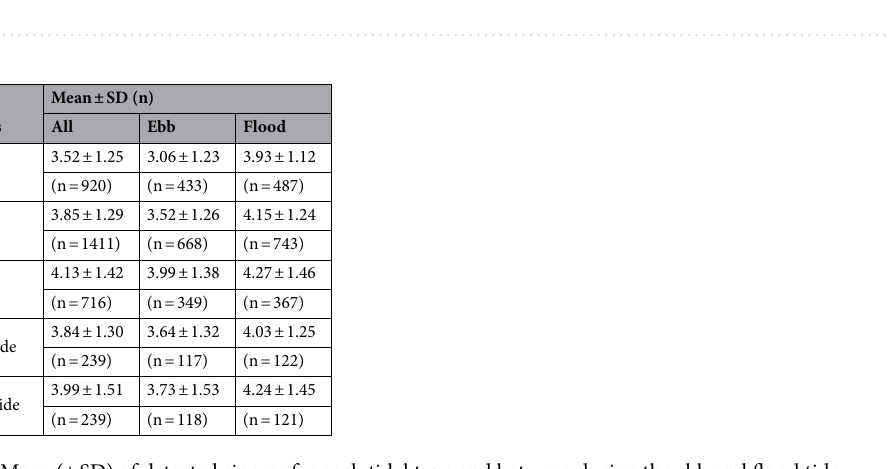
Table 1. Mean (± SD) of detected singers for each tidal type and between during the ebb and flood tide periods.